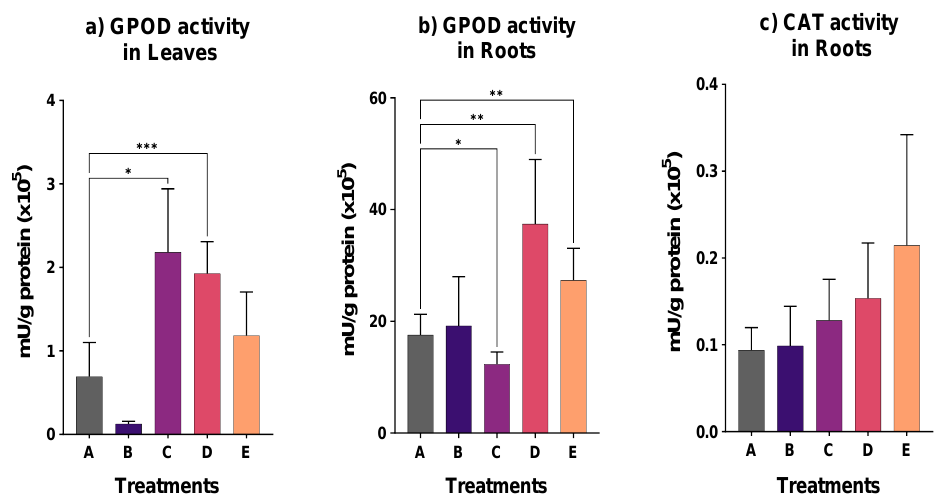
Figure 4. Specific guaiacol peroxidase in ( a ) leaves, ( b ) roots and ( c ) catalase activity in roots for all treatments (star indicates the level of significance: * for p < 0.05, ** for p < 0.01, *** p < 0.001). In Figure 5, the Sb content accumulated in roots and leaves is shown. In Sb-contaminated soils, the highest content was detected in treatment E, with 58.10 mg/kg DW biomass in the roots and 3.38 mg/kg DW biomass in the leaves. On the contrary, the lowest Sb concentration was found in treatment C, where again, the majority of the Sb remained in the roots. In the control with the background concentration of Sb, the accumulation was found to be 0.61 mg/kg DW biomass in the roots and 0.66 mg/kg DW biomass in the leaves. The estimated translocation factor was close to unity, much higher compared to all other treatments where Sb is present at a much higher concentration in the soil.